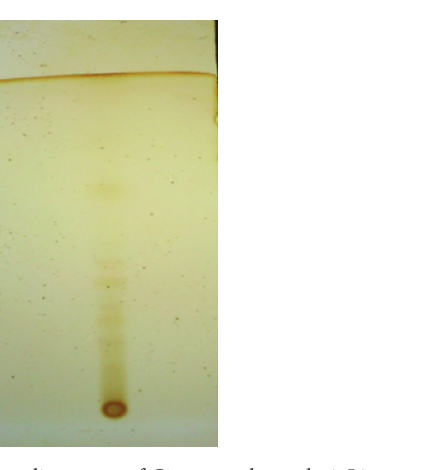
Figure 1: TLC of ethanolic extract of Cissus quadrangularis Linn.